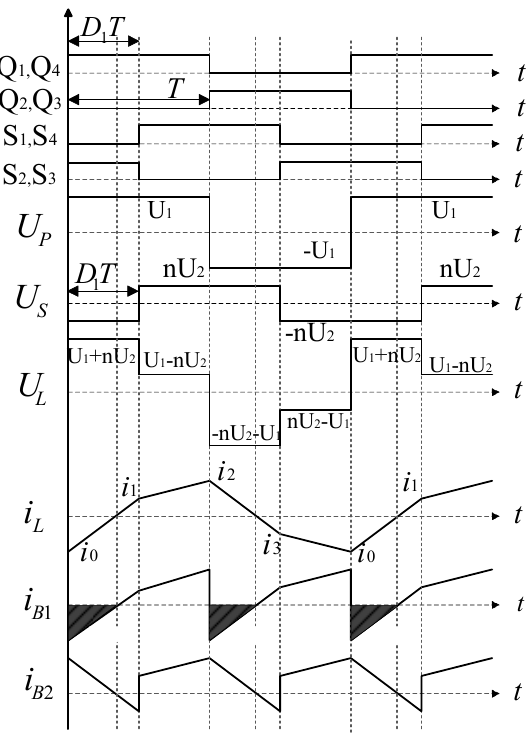
Figure 3. Waveforms of IBDC in CSPS